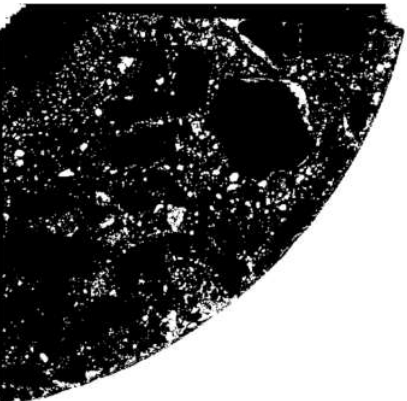
Figure 10. Image of sample after segmentation procedure Step 4.